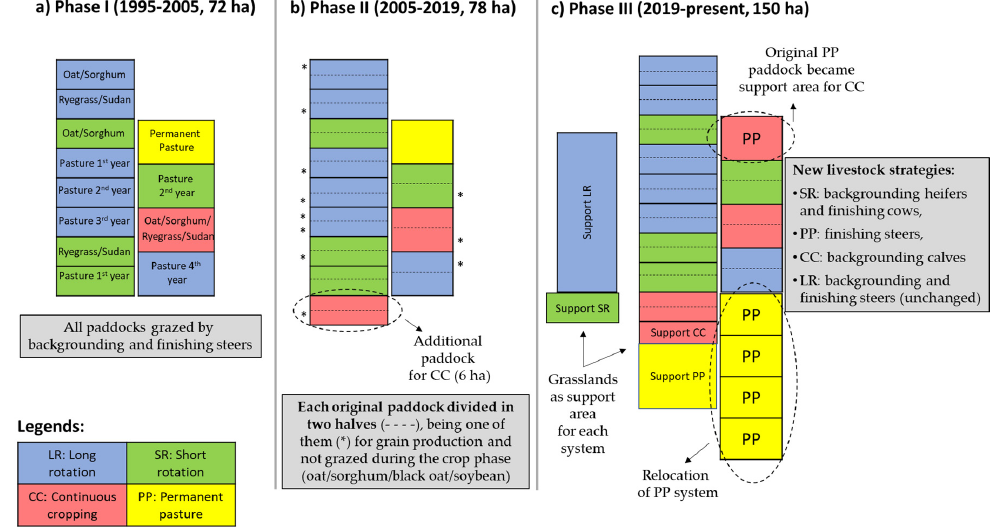
Figure 2. Field plot layout showing experimental design and chronological changes of the ‘Palo a Pique’ long-term experiment. Treatments: long rotation in blue (LR, two years of crops followed by four years of pastures); short rotation in green (two years of crops followed by two years of pastures); permanent improved pasture in yellow (PP); and continuous cropping in red (CC). All the phases of the rotations are present each year (the plot layout shown in Phase I represents an example of one particular